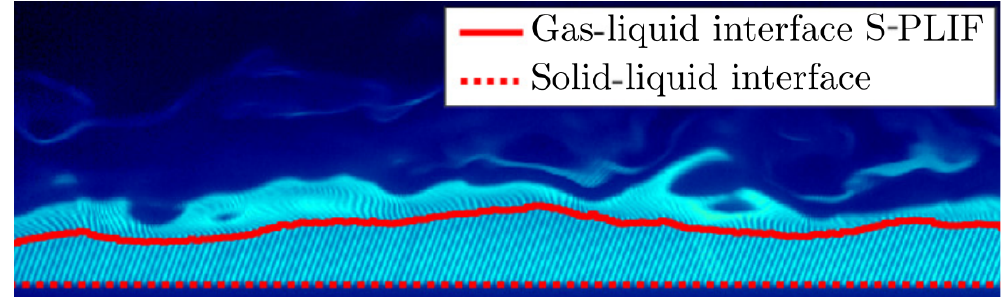
Figure 5. Identification of the true interface by the breaking shadows cast by the structuring grid at the true interface, thick falling film in a vertical circular pipe [70].